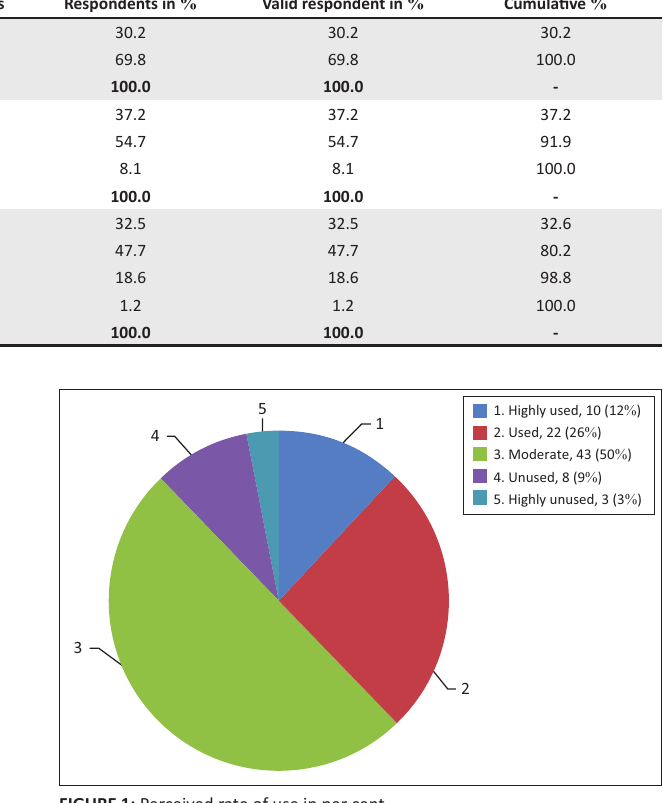
FIGURE 1: Perceived rate of use in per cent.